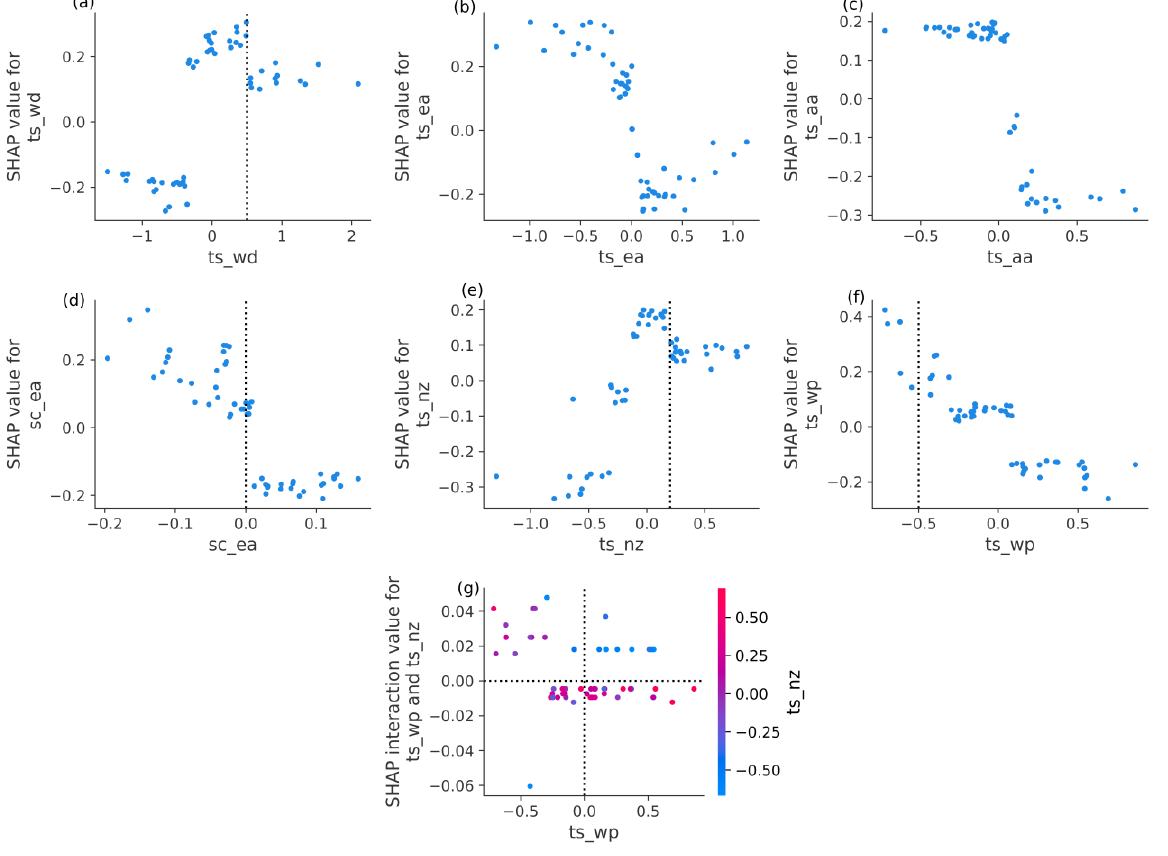
Figure 5. The dependence plots of six important features ( a – f ). The interaction dependence plot of ts_wp and ts_nz ( g ). The dots indicate the samples.